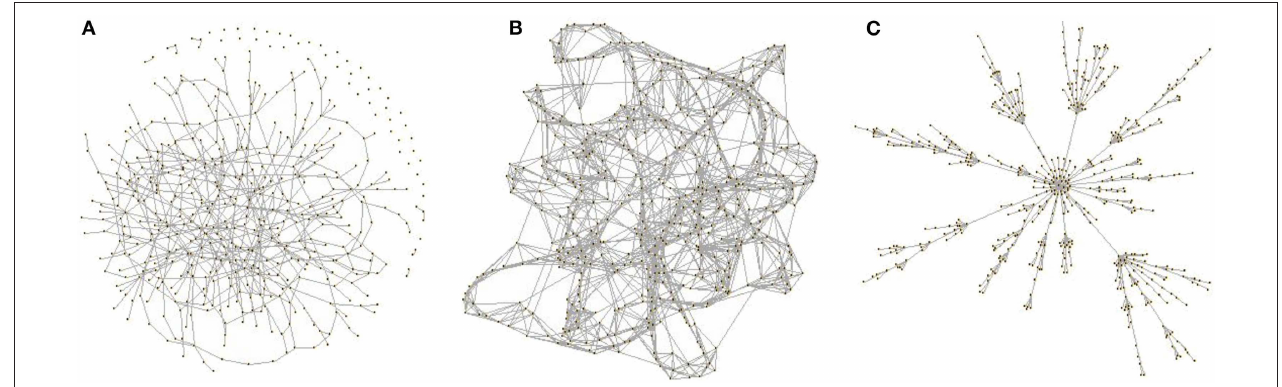
FIGURE 5 | Network models. (A) An Erdos–Rényi random network. (B) A Watts-Strogatz network. (C) Barabási–Albert (BA) scale-free network. Graphs were visualized using R. Code example: g1 = sample_smallworld (1, size = 500, nei = 4, p = 0.03). Plot (g1, layout = layout.fruchterman.reingold, vertex.label = NA, edge.arrow.size = 0.02, vertex.size = 0.5, xlab = “Random Network: G(N,p) model”)